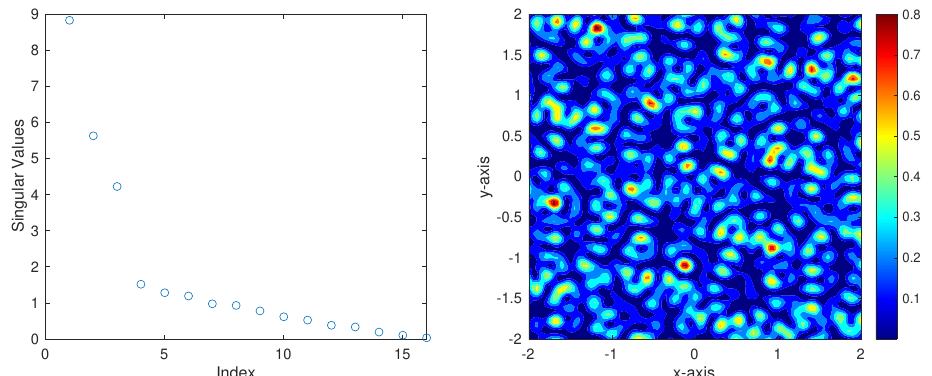
Figure 11. Singular value distribution and imaging results for output data from a model learned with 10,000